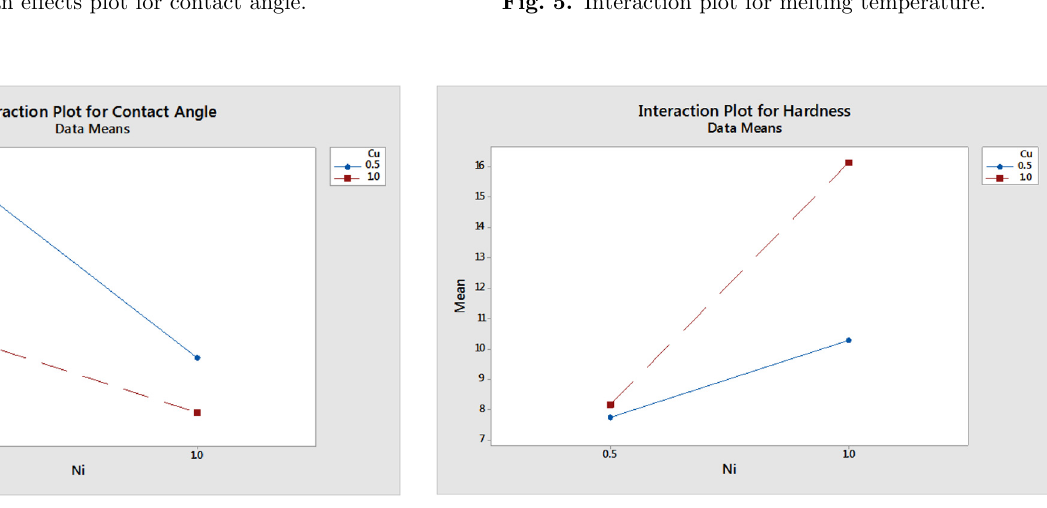
Fig. 6. Interaction plot for